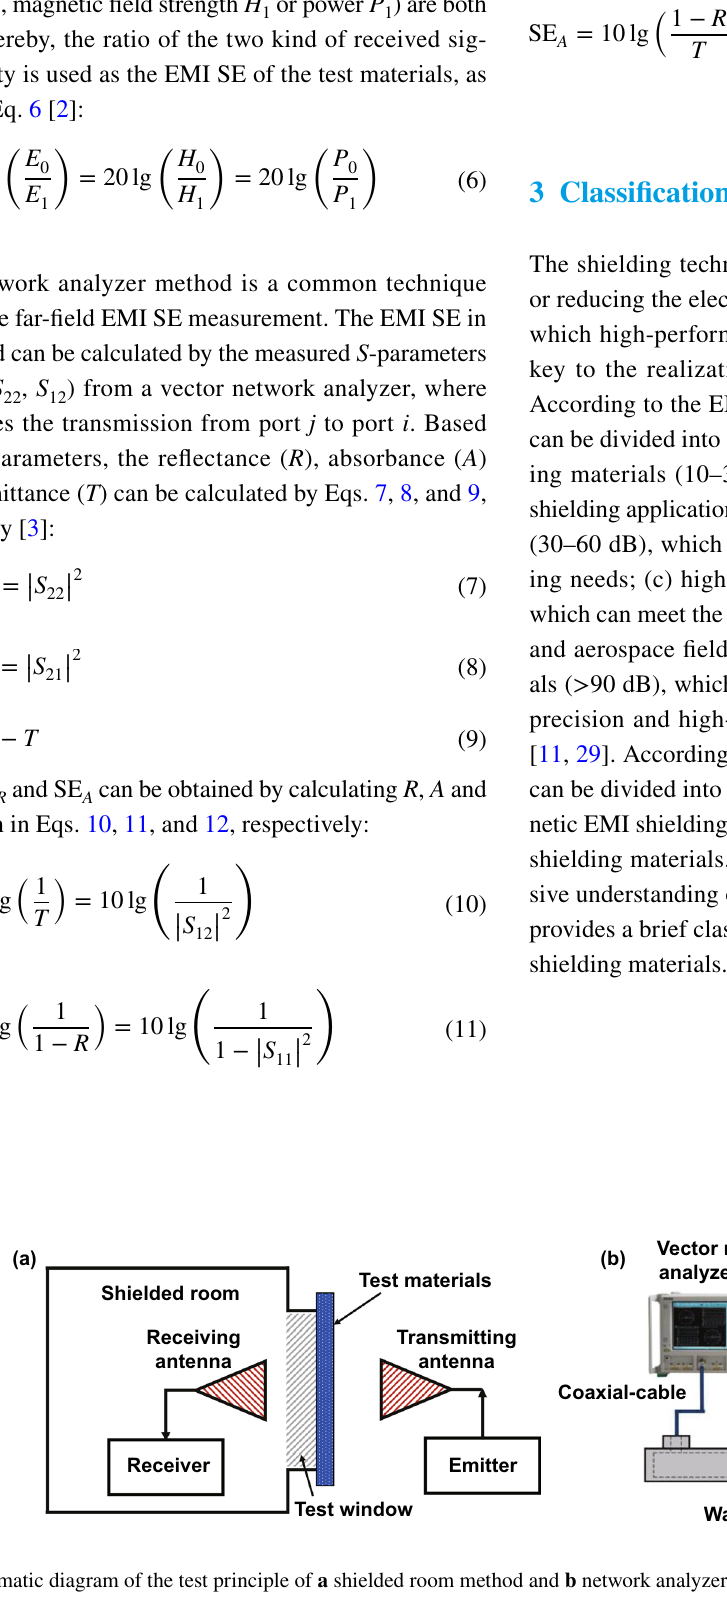
Fig. 4 Schematic diagram of the test principle of a shielded room method and b network analyzer